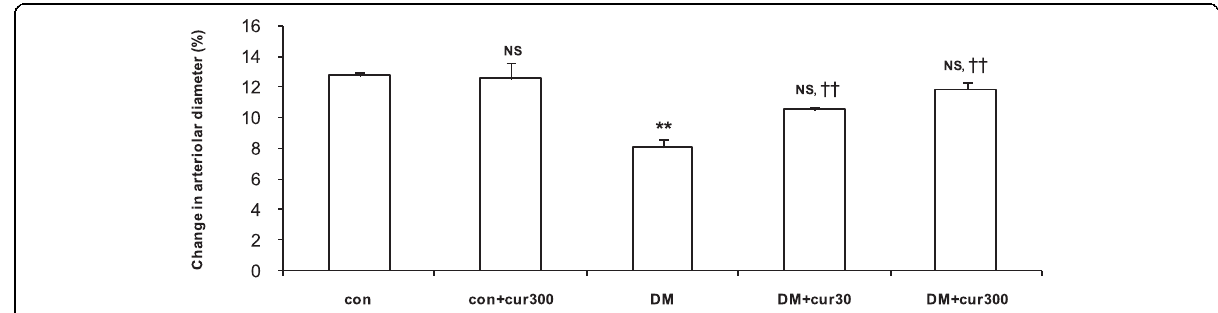
Figure 2 Acetylcholine-induced arteriolar vasodilation . Acetylcholine-induced changes in mesenteric arteriolar diameters from control (con), diabetes (DM) and curcumin-treated groups (DM+cur30, DM+cur300 and con+cur300). Data are means ± SEM (n = 5 for each group). NS, not significant different compared to control arterioles; ** P < 0.01, significant difference compared to control arterioles; †† P < 0.01, significant difference compared to diabetic